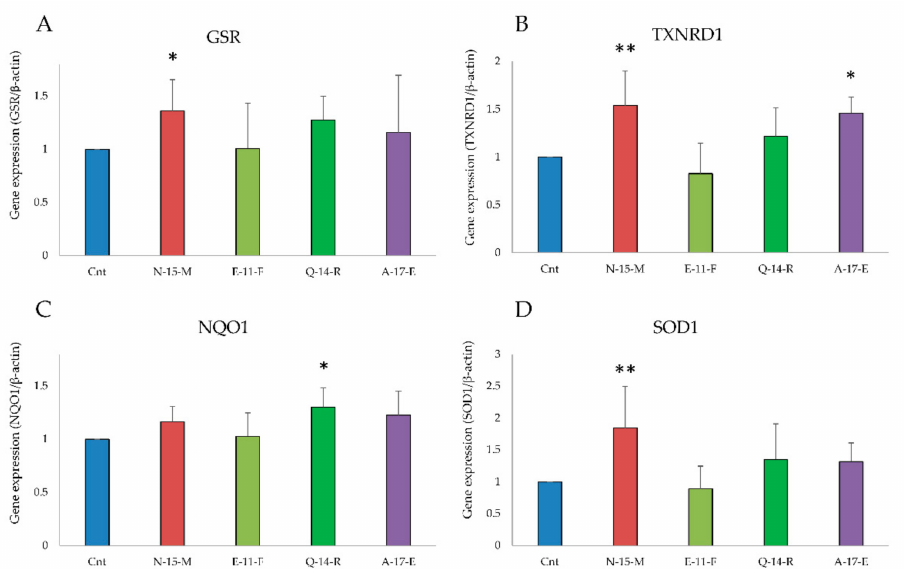
Figure 4. Antioxidant enzymes gene expression analysis. The gene expression of glutathione reductase (GRS, A ), thioredoxin reductase (TXNRD1, B ), NADPH quinone oxidoreductase (NQO1, C ) and superoxide dismutase (SOD1, D ) was evaluated in cDNA obtained from Caco-2 cells treated with N-15-M , E-11-F , Q-14-R and A-17-E (0.05 mg / mL) for 24 h. β -actin was used as reference. Means of at least four experiments were compared with the control. (** p < 0.01, * p <